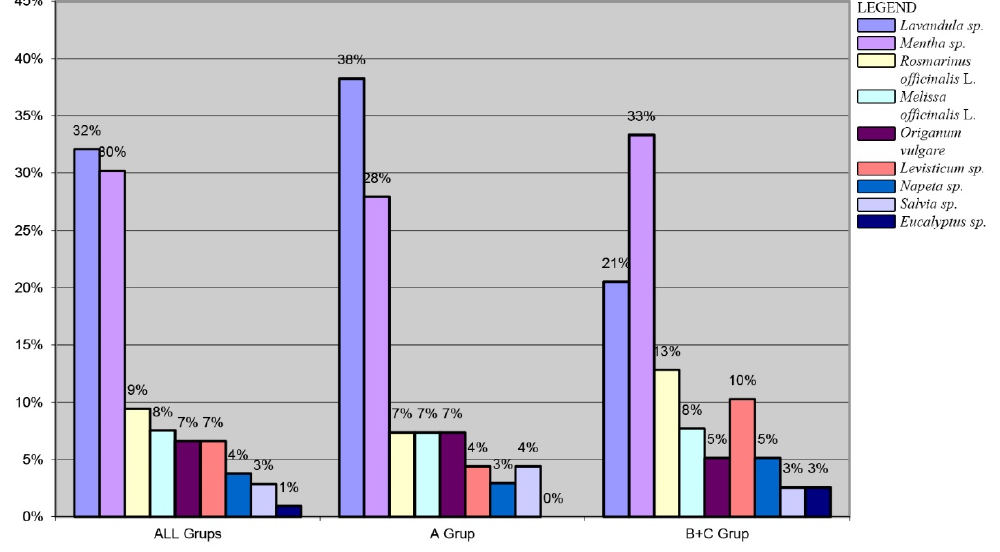
Table 3. Specific associations with past events listed by respondents as tied with preferred aromatic herbs.